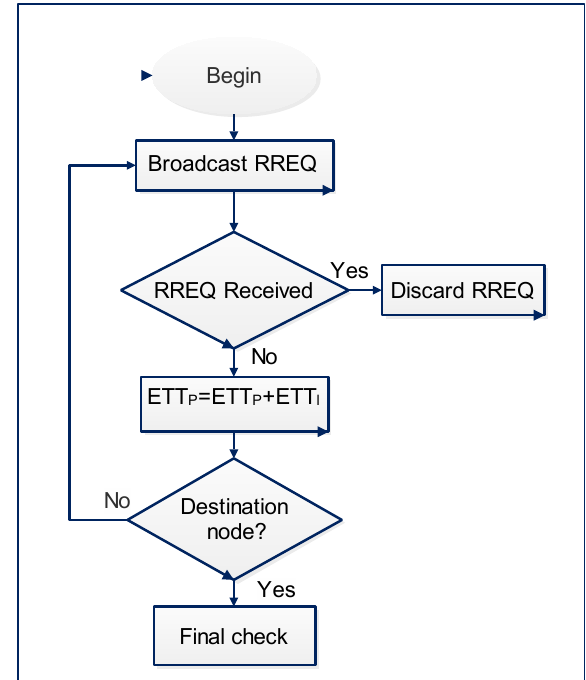
Figure 5. The ETT-Check procedure